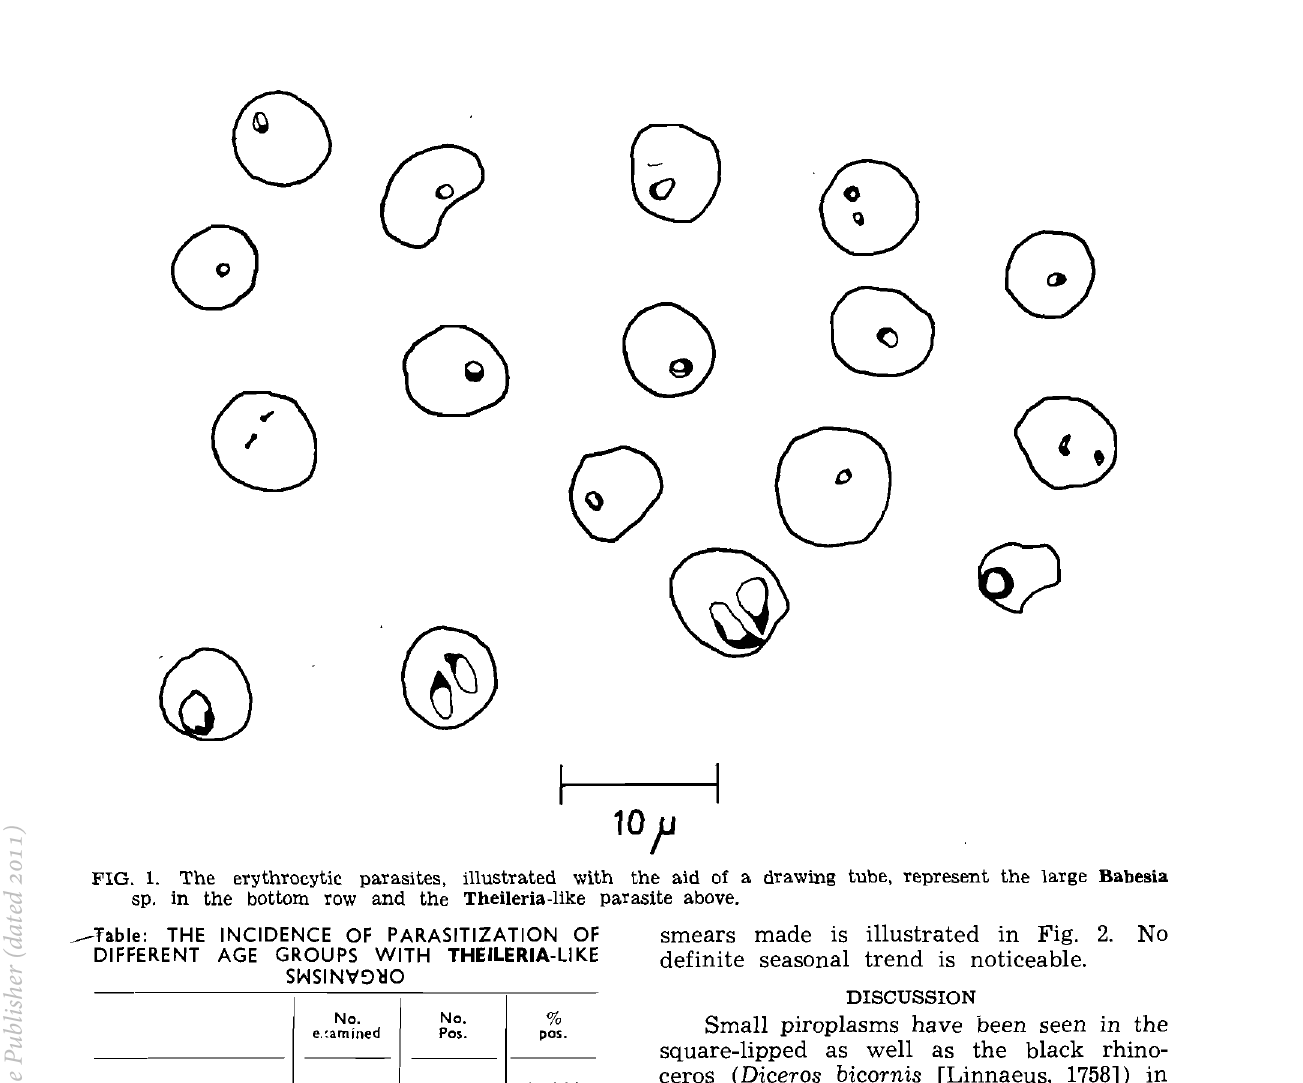
FIG. 1. The erythrocytiC parasites, illustrated with the aid of a drawing tube, represent the large Babesia sp. in the bottom row and the Theileria-like parasite above. _____ Table: THE INCIDENCE OF PARASITIZATION OF DIFFERENT AGE GROUPS WITH